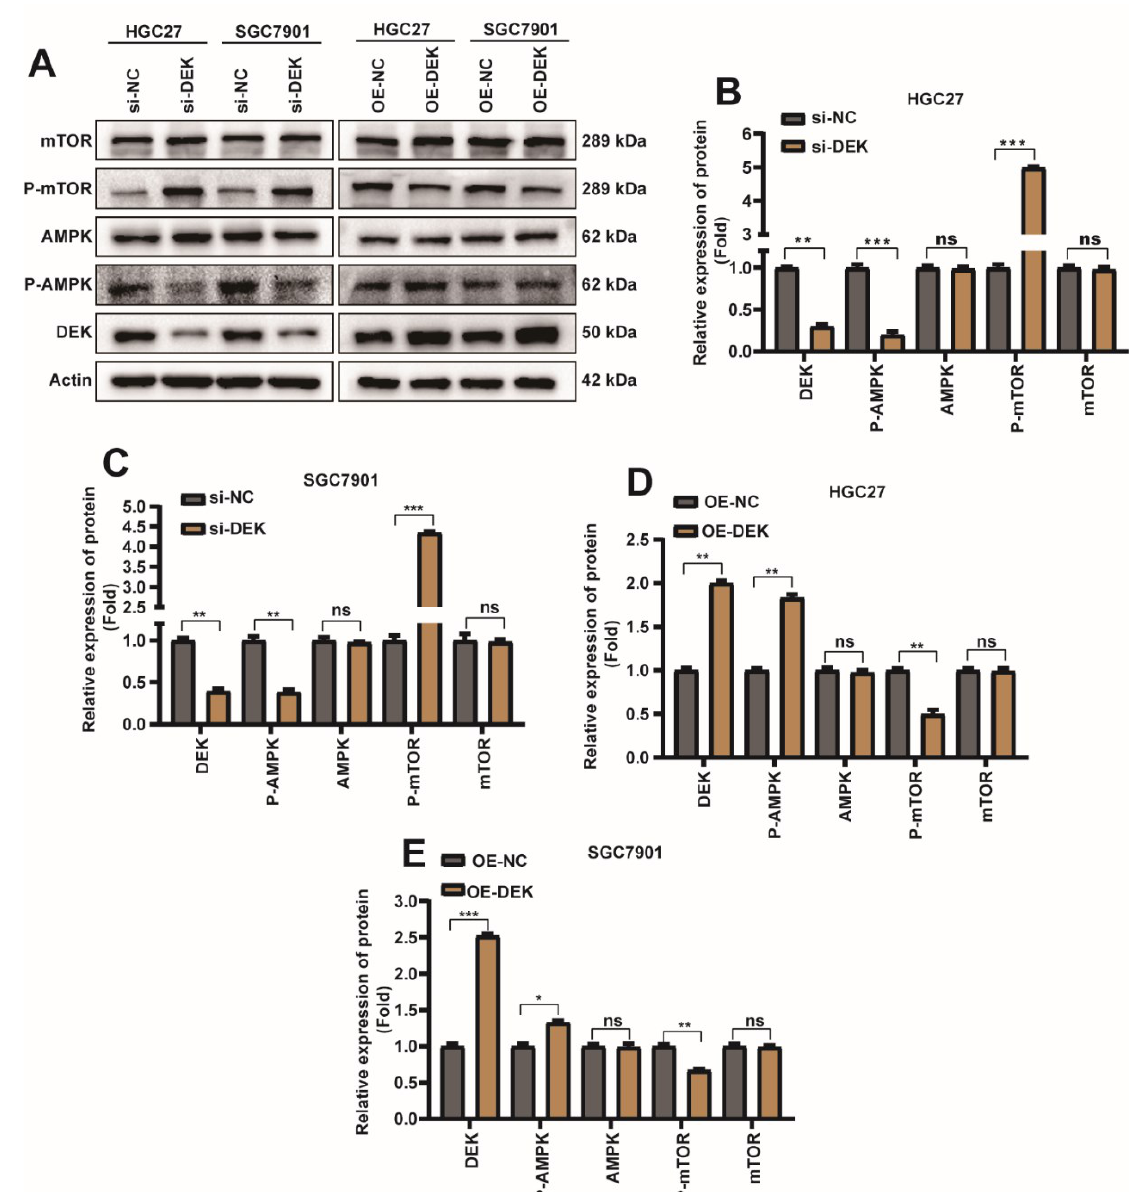
Figure 4. DEK promotes autophagy and inhibits apoptosis in GC through AMPK/mTOR signaling pathway. si-DEK/si-NC was transfected into HGC27/SGC7901 cell line, similarly OE-DEK/OE-NC